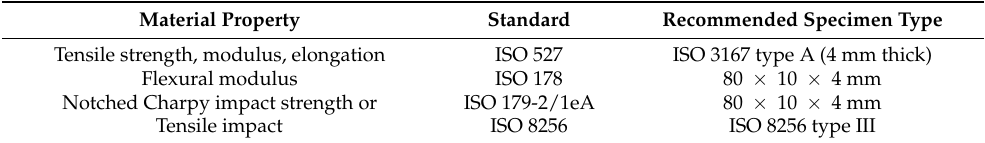
Table 2. Mechanical property testing items in ISO 11114-5